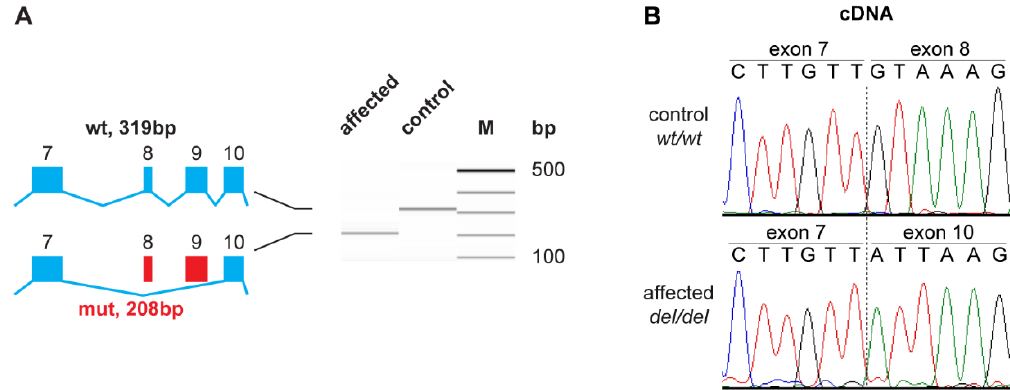
Figure 4. Experimental confirmation of the splice defect on the transcript level. ( A ) RT-PCR analysis of MIA3 transcripts in an affected and a non-affected dog. Fragment Analyzer bands of the products in the control animal show the expected 319 bp band, while only a shorter 208 bp band is visible in the affected animal. The difference in fragment sizes is 111 bp, which corresponds to the combined length of exons 8 and 9; ( B ) Sanger sequencing of the RT-PCR products confirmed the breakpoints of the aberrant splicing product.